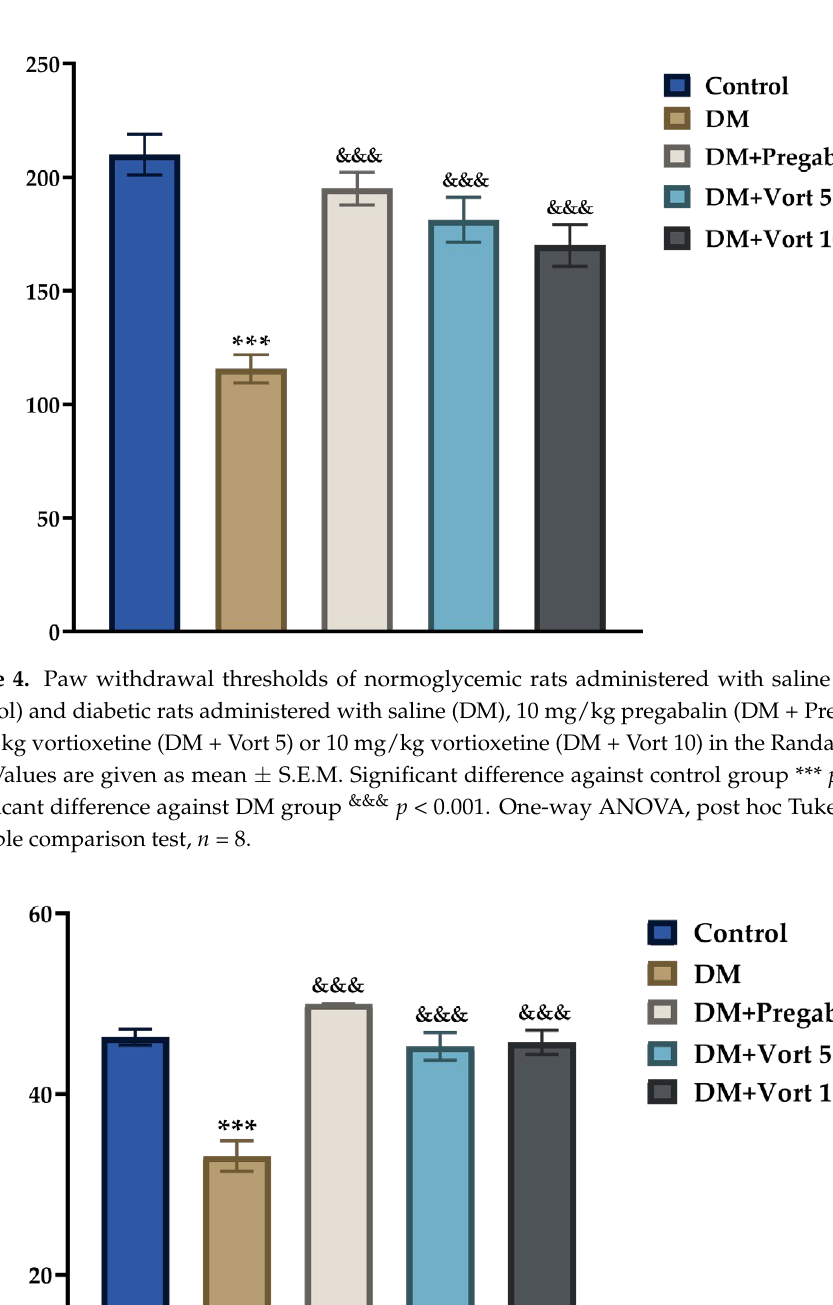
Figure 4. Paw withdrawal thresholds of normoglycemic rats administered with saline solution (con- trol) and diabetic rats administered with saline (DM), 10 mg/kg pregabalin (DM + Pregabalin), 5 mg/kg vortioxetine (DM + Vort 5) or 10 mg/kg vortioxetine (DM + Vort 10) in th e Randall– Selitto test. Values are given as mean ± S.E.M. Significant difference against control group *** p < 0.001; s ignificant difference against DM group &&& p < 0.001. One-way ANOVA, post hoc Tukey ’s HSD multiple comparison test, n = 8.